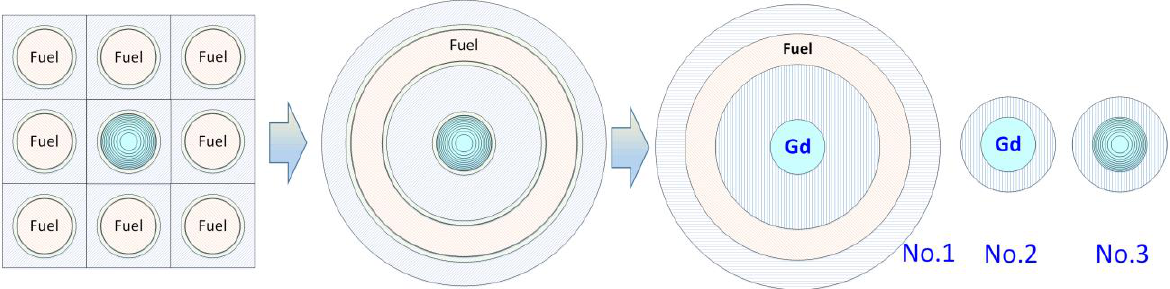
Figure 1. Geometric configurations of the improved